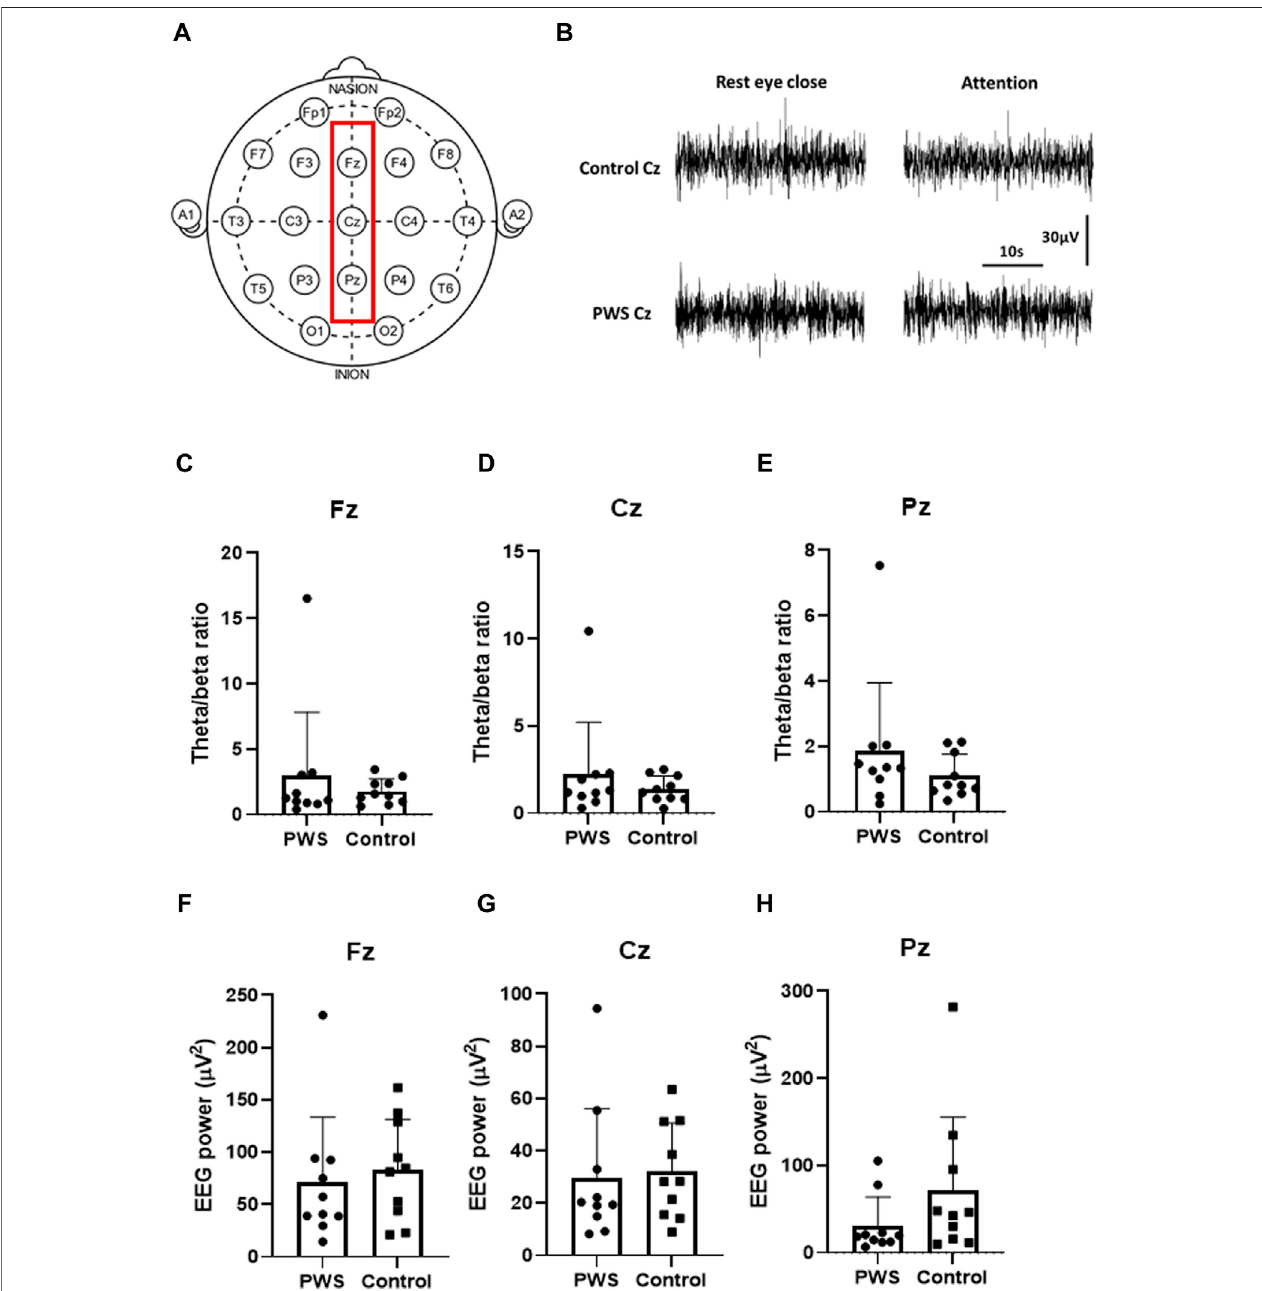
FIGURE 1 | Quantitative electroencephalographic (EEG) analysis during the resting state. (A) Schematic representation of the surface EEG of the International 10 – 20 system. The red square re fl ects the midline electrodes (Fz, Cz, and Pz) that were analyzed in this study. (B) Representative raw traces of Cz EEG in a control participant and a patient with PWS. (C – E) Theta/beta ratio of Fz (C) , Cz (D) , and Pz (E) during the resting state revealed no signi fi cant differences in patients with PWS and control participants. (F – H) 0-50-Hz EEG power of Fz (F) , Cz (G) , and Pz (H) during the resting states showed no signi fi cant differences in patients with PWS and control